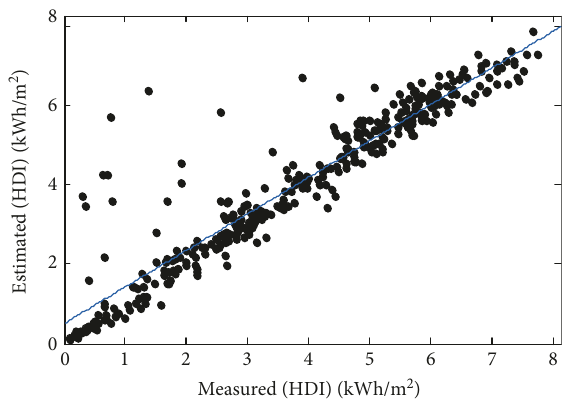
Figure 11: Regression plot of measured and estimated horizontal direct solar